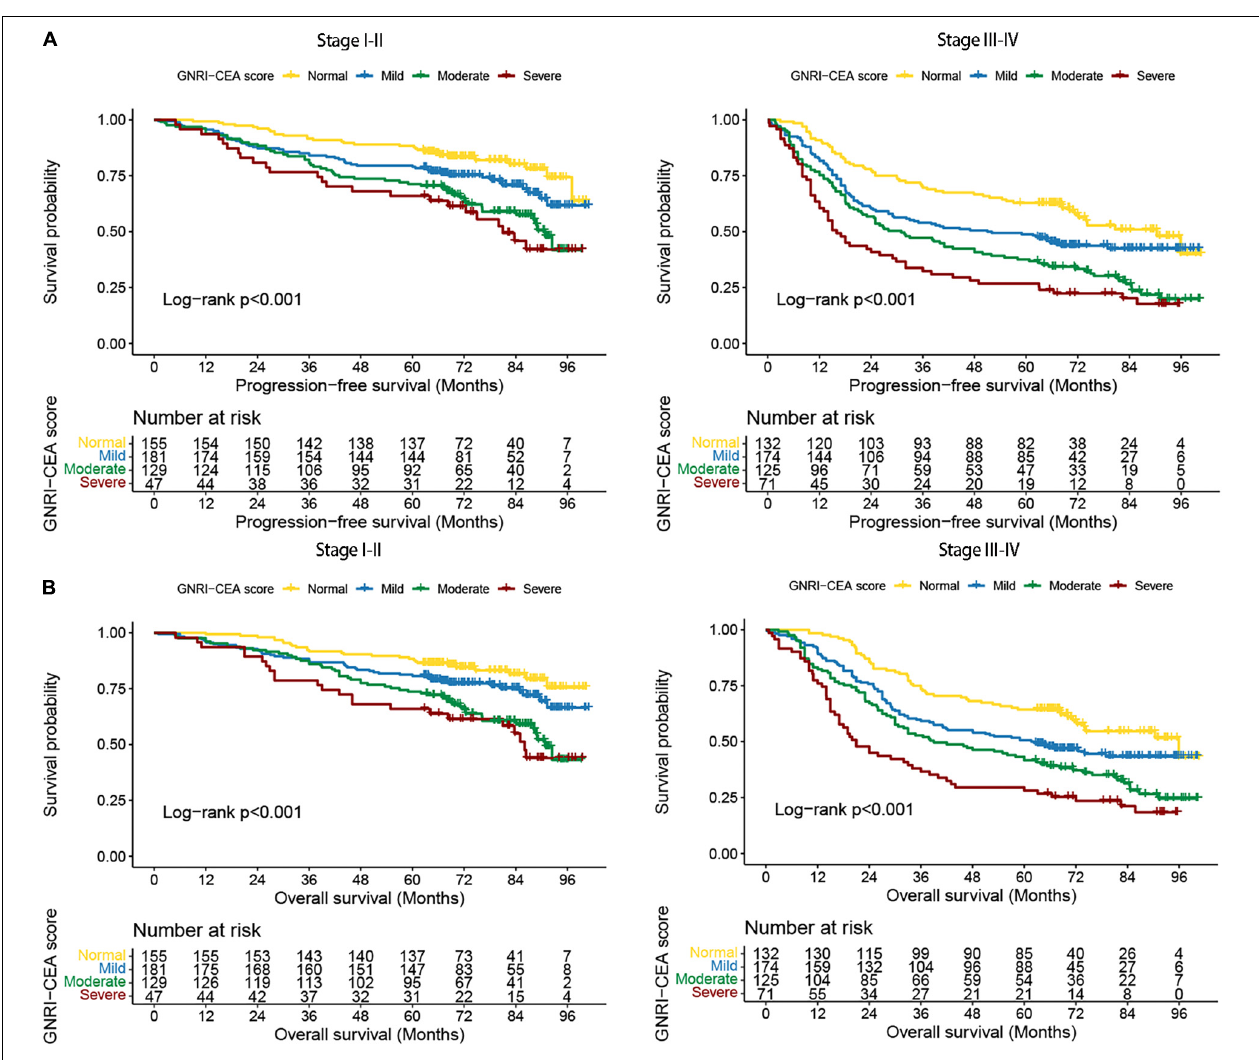
FIGURE 2 | Stratified survival analysis of GNRI-CEA score based on TNM stage. (A) PFS; (B) OS.